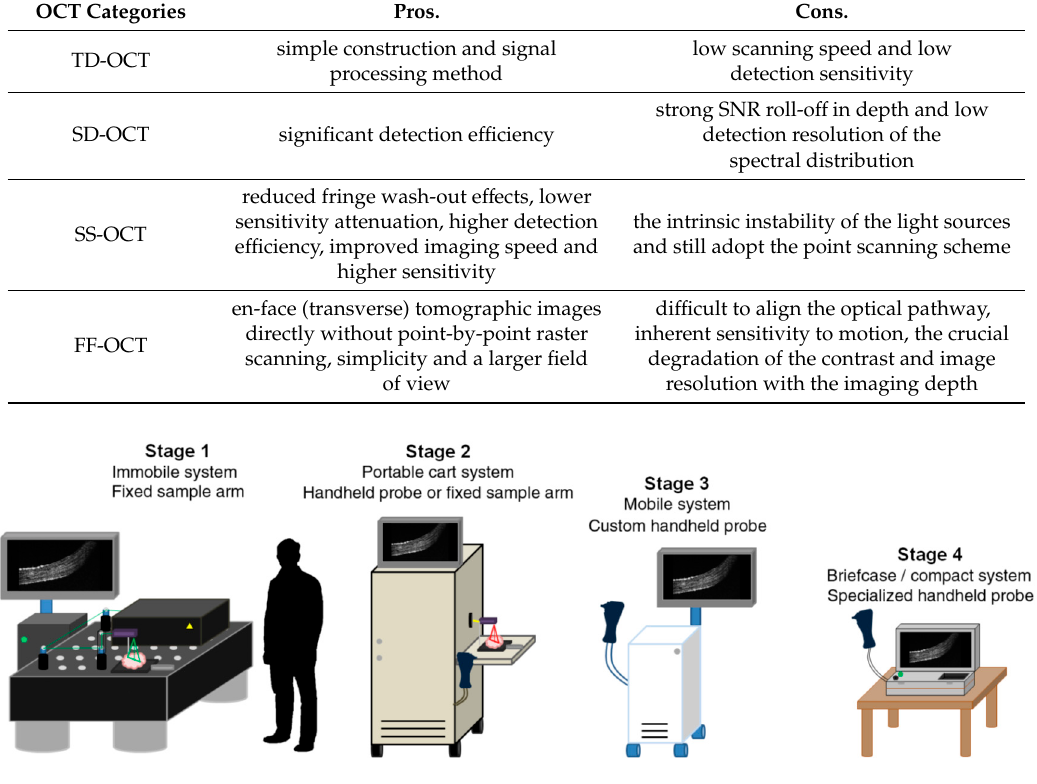
Figure 19. The trend of the development of OCT systems [147].